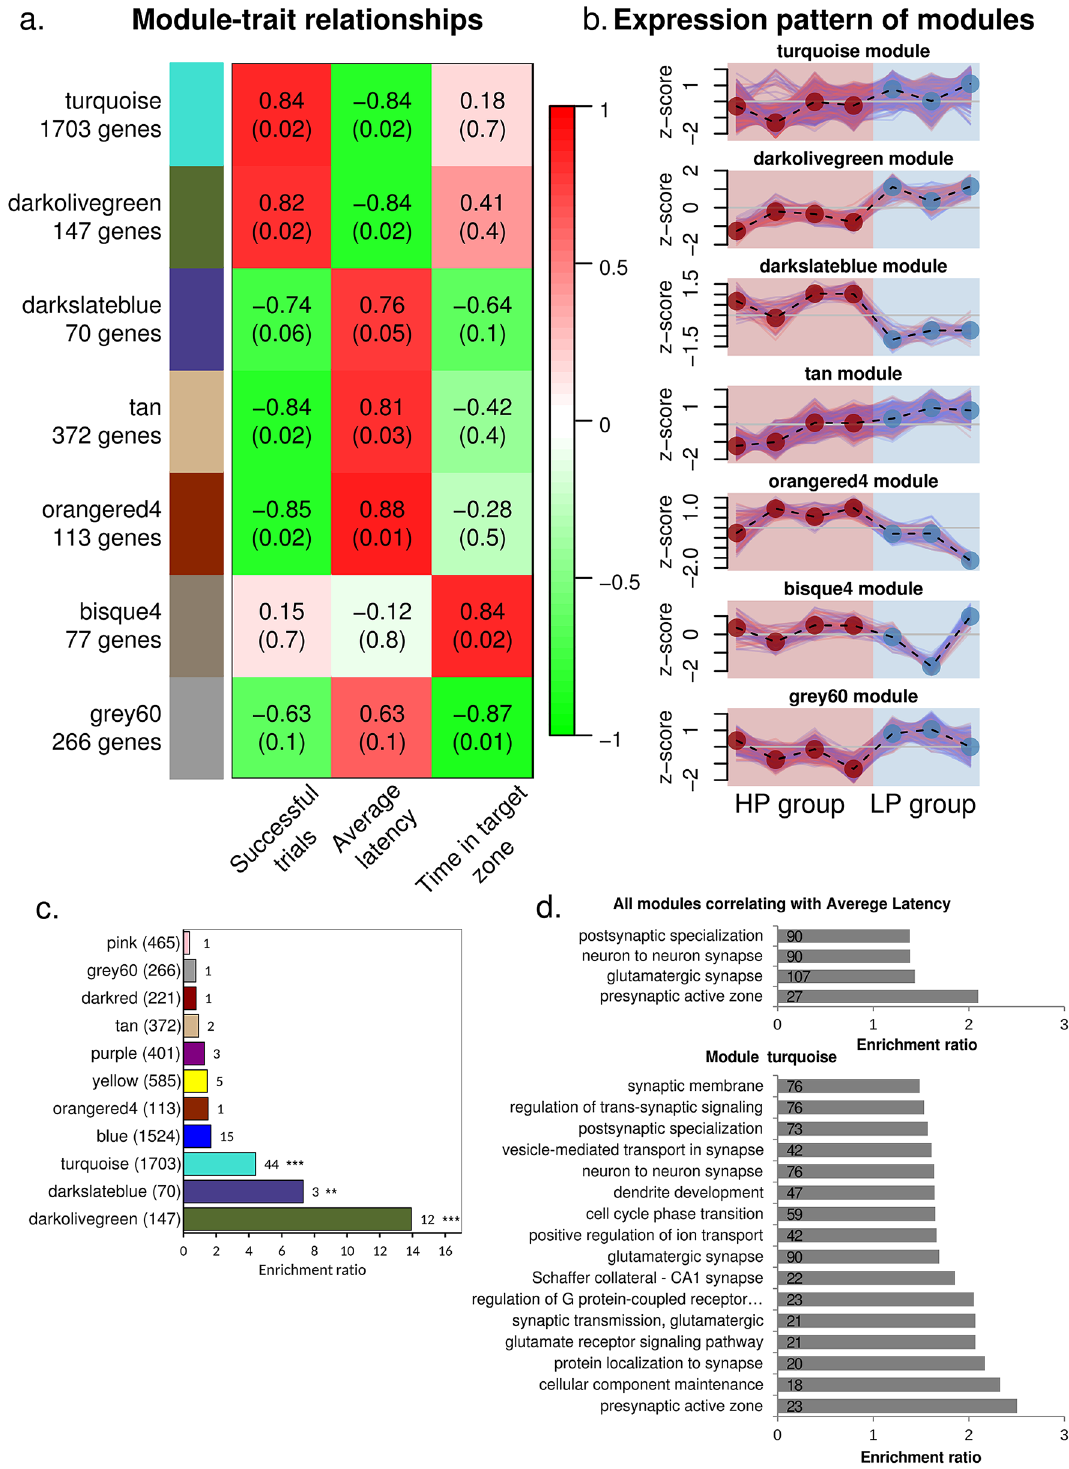
Figure 4. Functional characterization of co-expression modules. ( a ) The heatmap of module–trait relationships for behavioral data. Only modules significantly correlating with behavioral traits are shown. Cell color and number represent the coefficient and p value of Pearson’s correlation. Module names are accompanied by the number of corresponding genes. ( b ) The expression pattern of modules. The y-axes represent the z-score of rLog-transformed counts. Lines indicate a scaled expression pattern of each gene. The dashed line indicates the mean value of the expression. Point colors correspond to experimental groups. ( c ) The bar plot illustrating the enrichment of gene modules with DEGs. Numbers in bars indicate the found DEGs. Values > 1 mean enrichment of this module with DEGs, and values < 1 denote depletion of DEGs. Fisher’s test, *** p < 0.001, ** p < 0.01. ( d ) GO term enrichment analysis of all modules that showed high correlation with the average latency to find the platform, and below, the data from separate GO analyses of the turquoise module. The number of genes in a category is shown inside each plot. Both analyses identified enrichment of the terms related to the glutamatergic